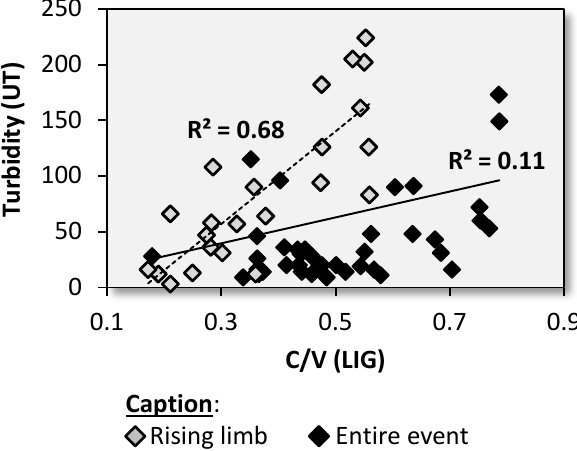
Figure 5. Variation in the C / V ratio (lignin proxy) in SOM, soil DOM from organomineral and mineral horizons, and stream DOM sampled during inter-storm and storm conditions. Dates are given in day/month/year.